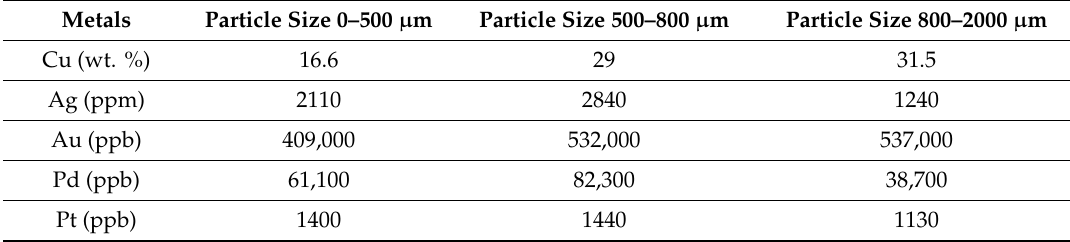
Table 1. Cu and precious metals content of printed circuit boards